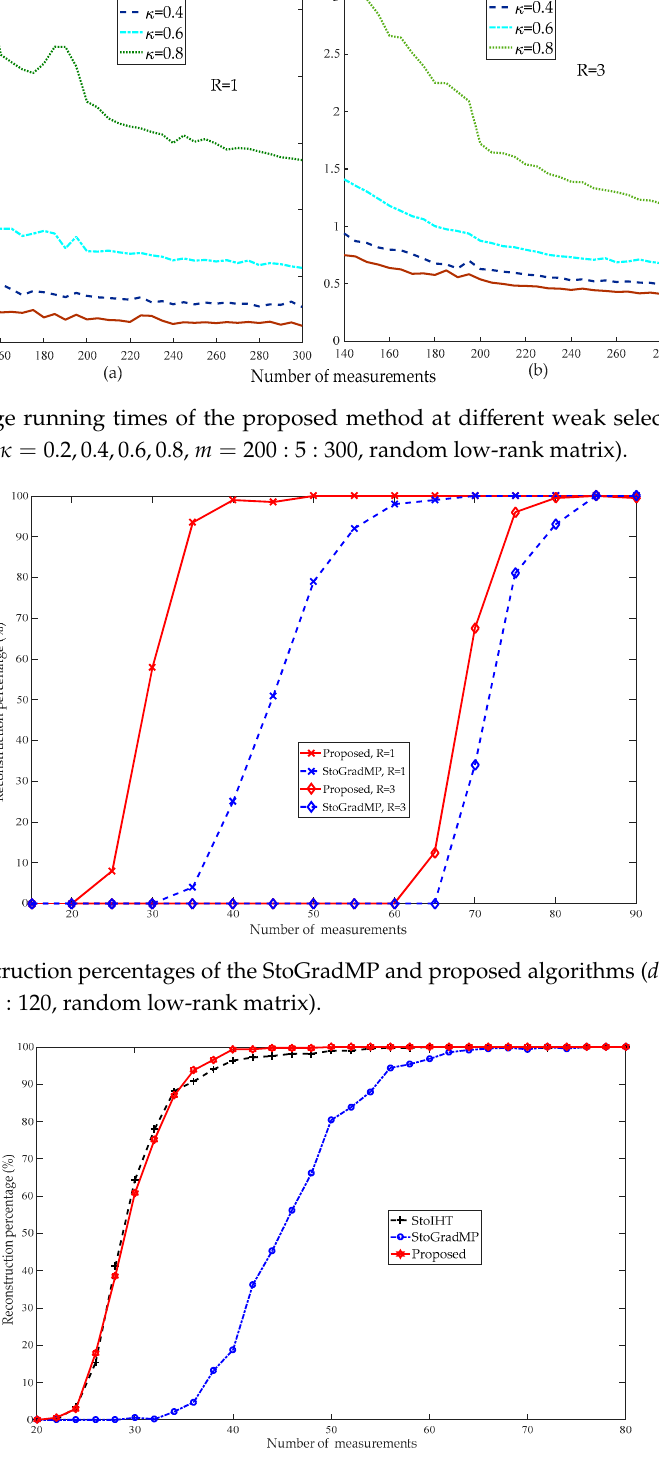
Figure 13. Reconstruction percentages of the different methods ( d = 100, R = 1, κ = 0.2, m = 20 : 2 : 70, randomly low-rank